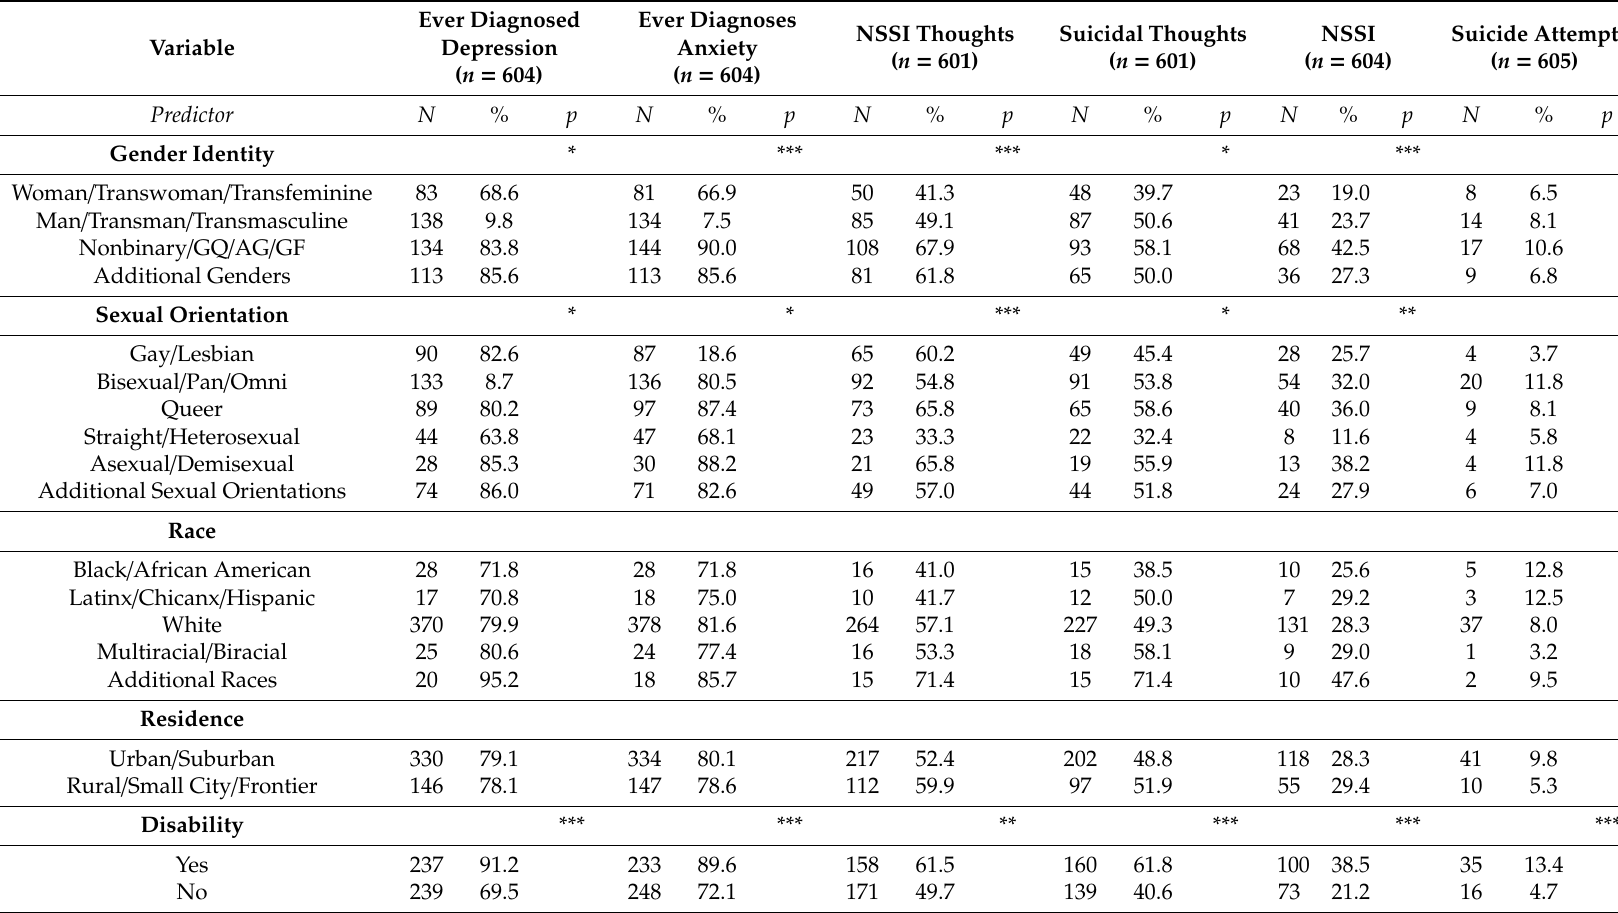
Table 2. Chi Square Tests of Independence of Demographics by Mental Health